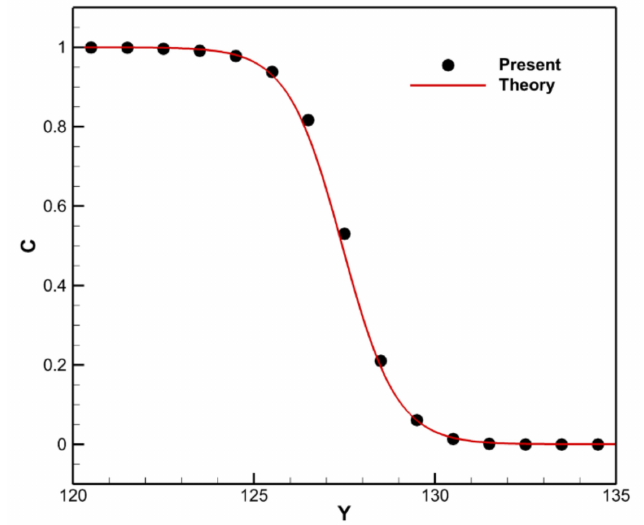
Figure 10. Contrast of the contour for the order parameter along the y-centerline with the analytical solution for σ = 0.005 at R =